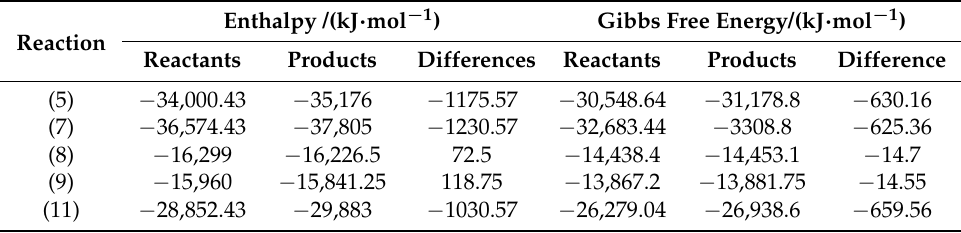
Table 4. Thermodynamic parameter changes of reactions might happened at 298